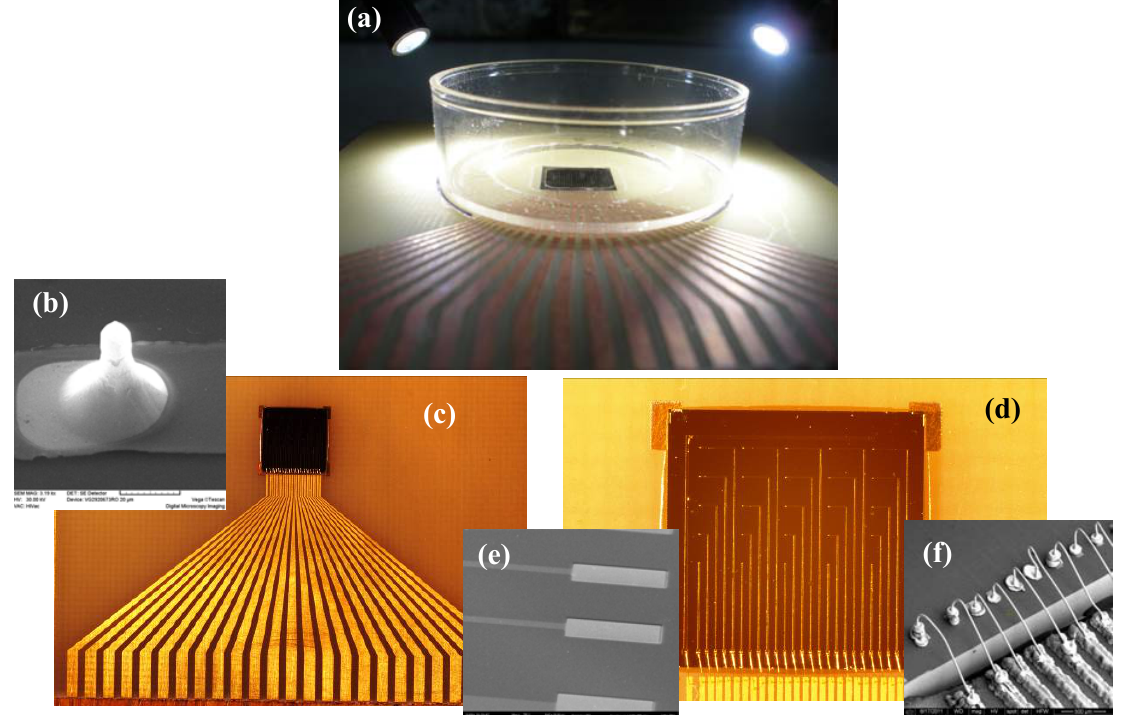
Figure 5. Photo-images of the final test structure ( a ) and respectively details of the PCB-mounted microchip ( c , d ); SEM images with details of one test electrode ( b ) and the microchip pads before and after their electrical connection with the PCB circuitry ( e , f